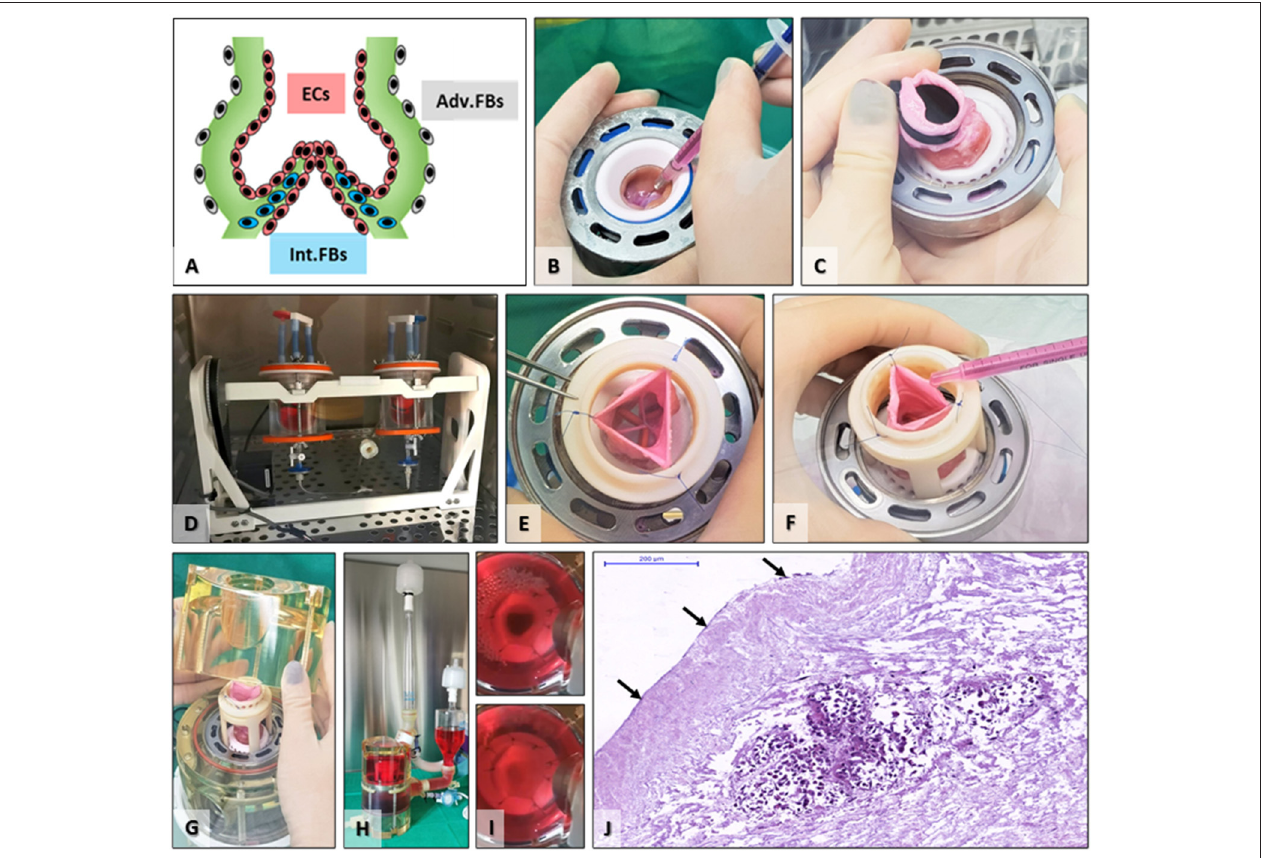
FIGURE 4 | Scaffold seeding and bioreactor preconditioning. (A) Schematic depicting the targeted cell distribution by seeding FBs internally (Int.FBs, blue) as well as adventitially (Adv.FBs, gray) and ECs in the root lumen, on cusps, sinus, and artery surfaces (ECs, red). (B) FBs seeding by injection in the base of each cusp. (C) Placing of an aortic plug to separate the lumen from the exterior environment. (D) TEHVs with aortic plugs placed in FBs suspension in the acrylic seeding cups on the rotator for adventitial seeding. (E) After removal of the plug, the pulmonary artery was temporarily maintained open using three or more single sutures, (E) for intraluminal seeding of ECs (F) . (G) Positioning the seeded valve in the bioreactor, (H) fully assembled heart valve bioreactor just before insertion in the incubator. (I) still shots saved from video recordings taken during valve conditioning in the bioreactor showing open (top) and closed (bottom) positions. (J) H&E staining of control TEHV (seeded and preconditioned, not implanted); arrows point to ECs surface coverage, while the cell-rich island in the middle is representative of interstitially injected